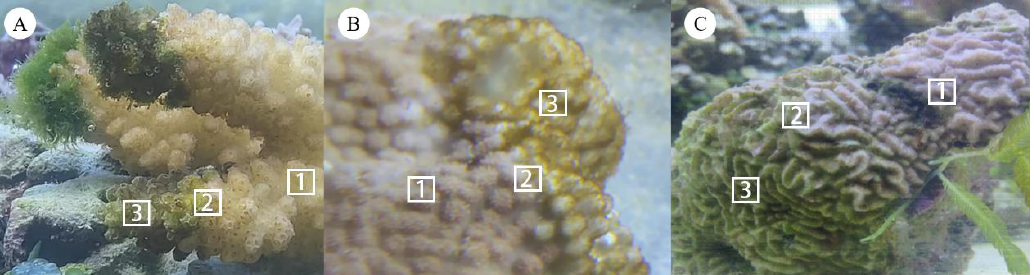
Figure 1. The appearance of algae-growth coral samples: ( A ) Pocillopora sp. (B ) Montipora sp. ( C ) Platygyra sp. 1, 2 and 3 represented HH, HA and AA samples, respectively.